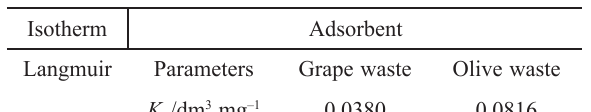
Table 2 – Parameters and correlation coefficient (R 2 ) of equilibrium isotherm models for the adsorption of Cr(VI) on grape and olive waste